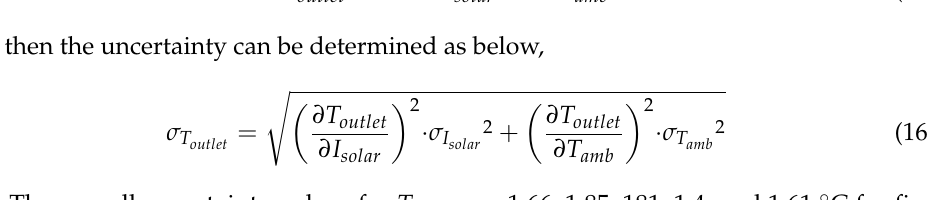
Figure 3. Optimal Flow path model ( a ) Model 3, selected based on the computational study, ( b ) Model 3-I, ( c ) Model 3-II, increased number of the flow path, ( d ) Optimal size of the solar heater with geometry.